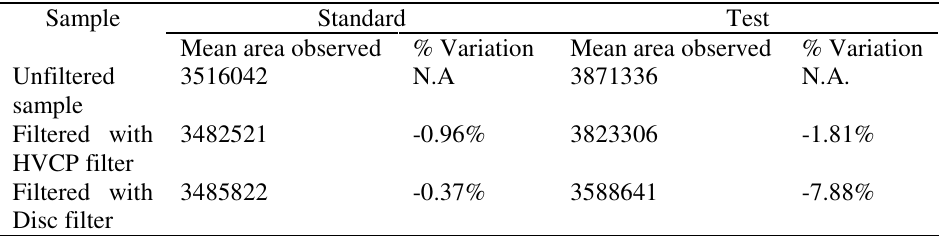
Table 5. Filter standardization data for developed